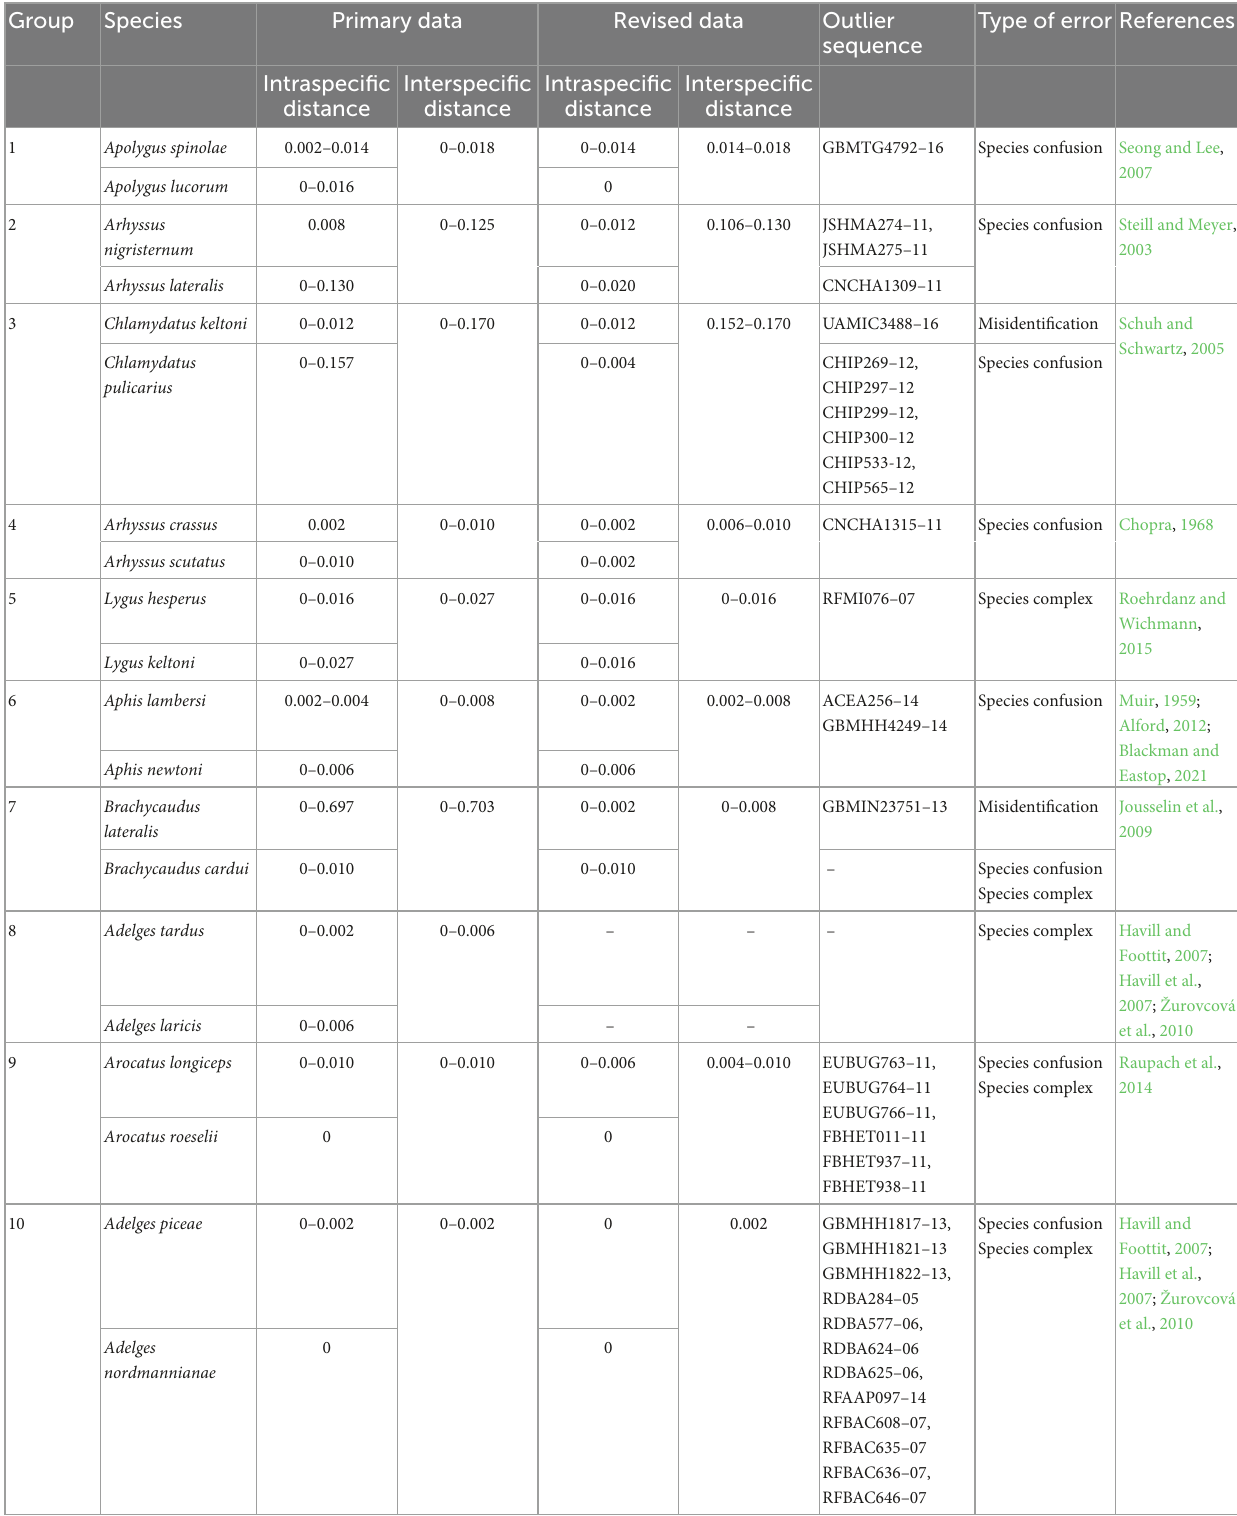
TABLE 2 Ten species pairs as interspecific genetic distance